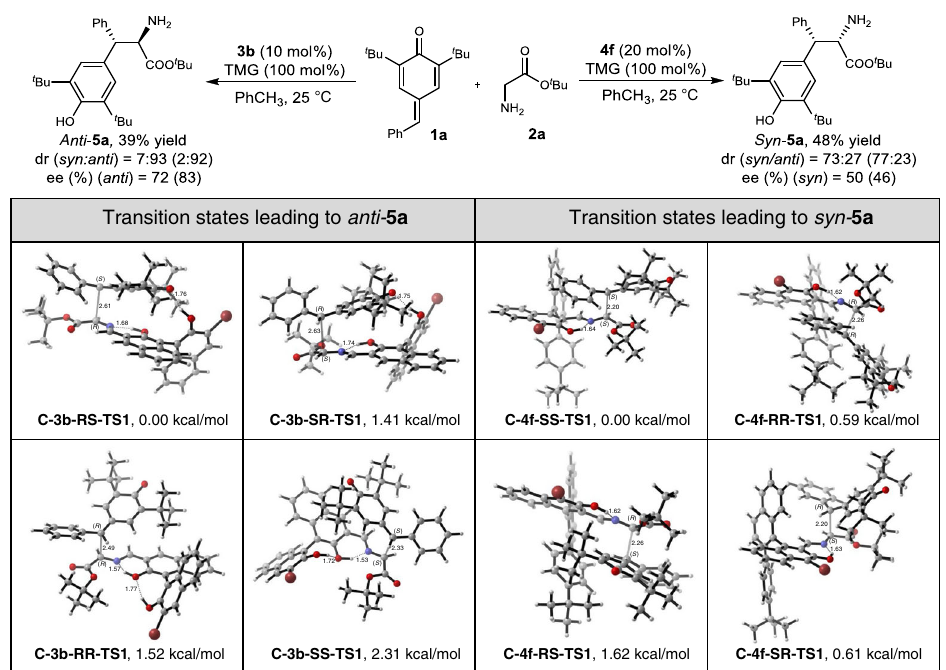
Fig. 4 Calculated transition states of the conjugated addition reaction. The structures of TSs to form 5a by the 1,6-conjugate addition catalysed by 3b and 4f at the M06-2X/6-31(d) // M06-2X/6-31 + + G(d,p) level and energy are given in kcal/mol relative energy of C-3b-RS-TS1 and C-4f-SS-TS1 . Dr and ee values shown in the parentheses are the predicted data given by computational